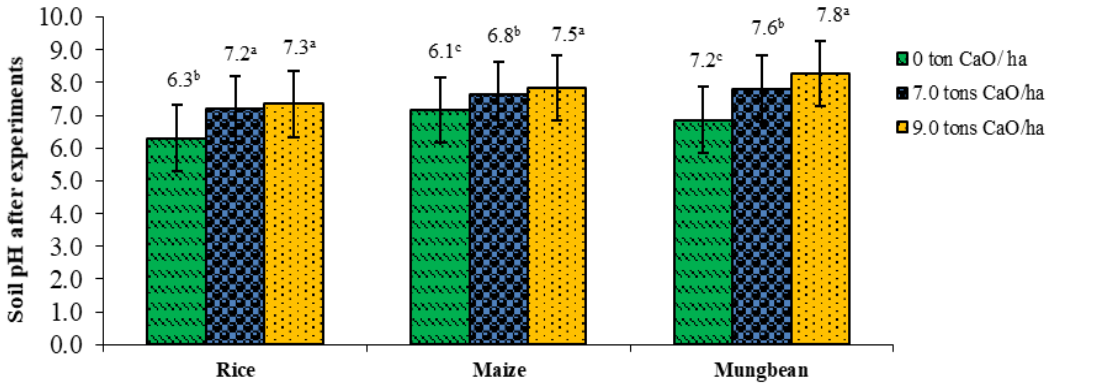
Fig.4. Effect of different lime ratios on soil pH after the